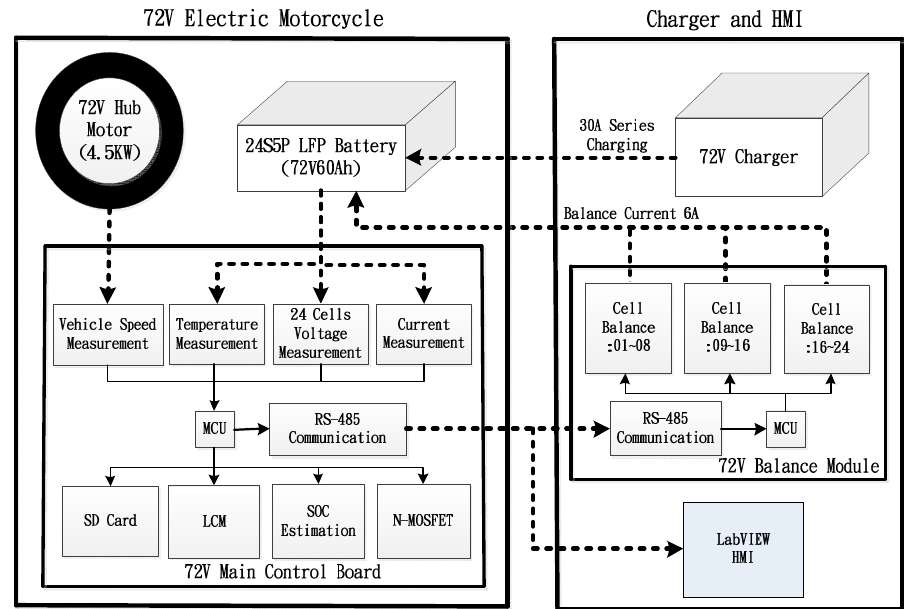
Figure 4. Proposed BMS system.